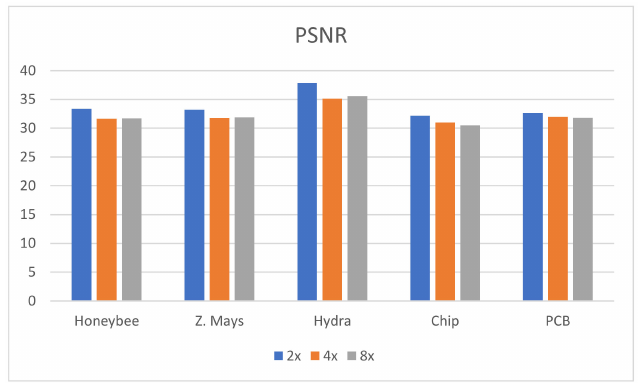
Figure 10. PSNR comparison between the × 2, × 4, and × 8 upscaling factors. The maximum value found for the × 2; however, compared to × 8, the difference is not more than 2.